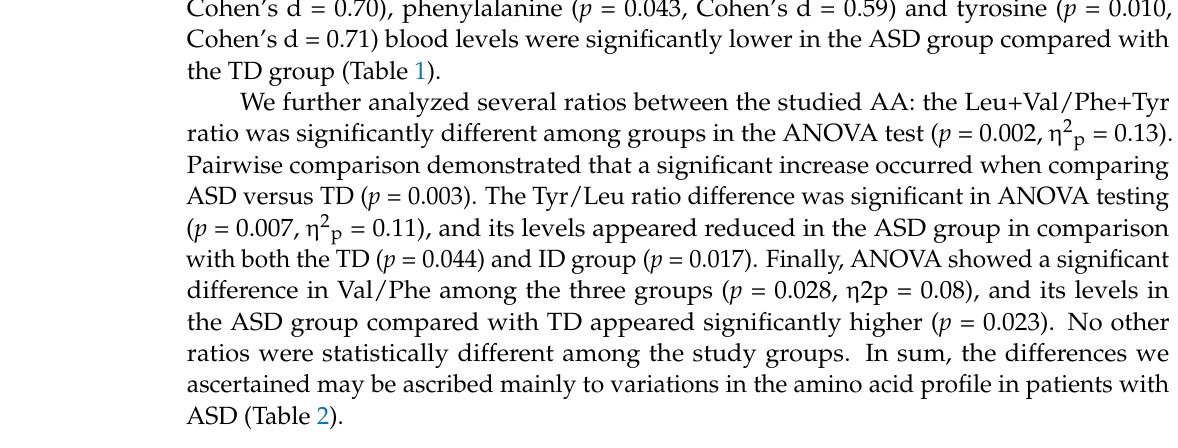
Table 2. Amino acid ratios comparison with ANOVA test in the three studied groups and paired post hoc comparisons with Bonferroni pairwise